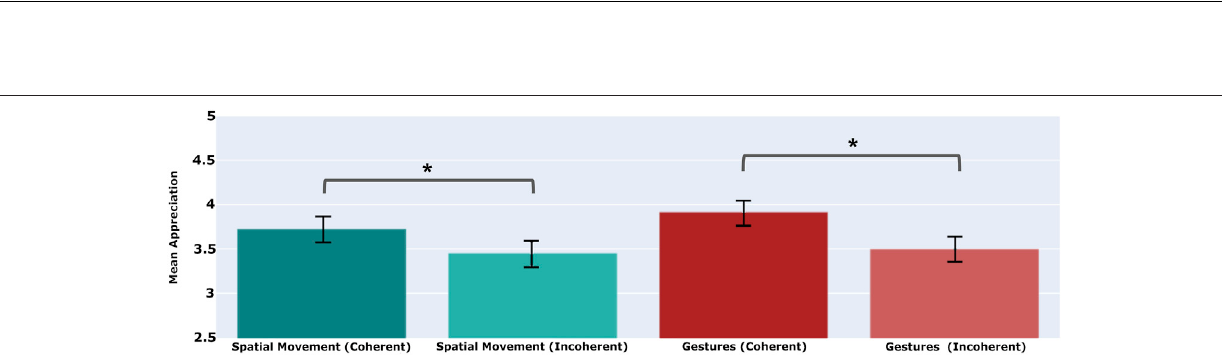
Frontiers in Robotics and AI |